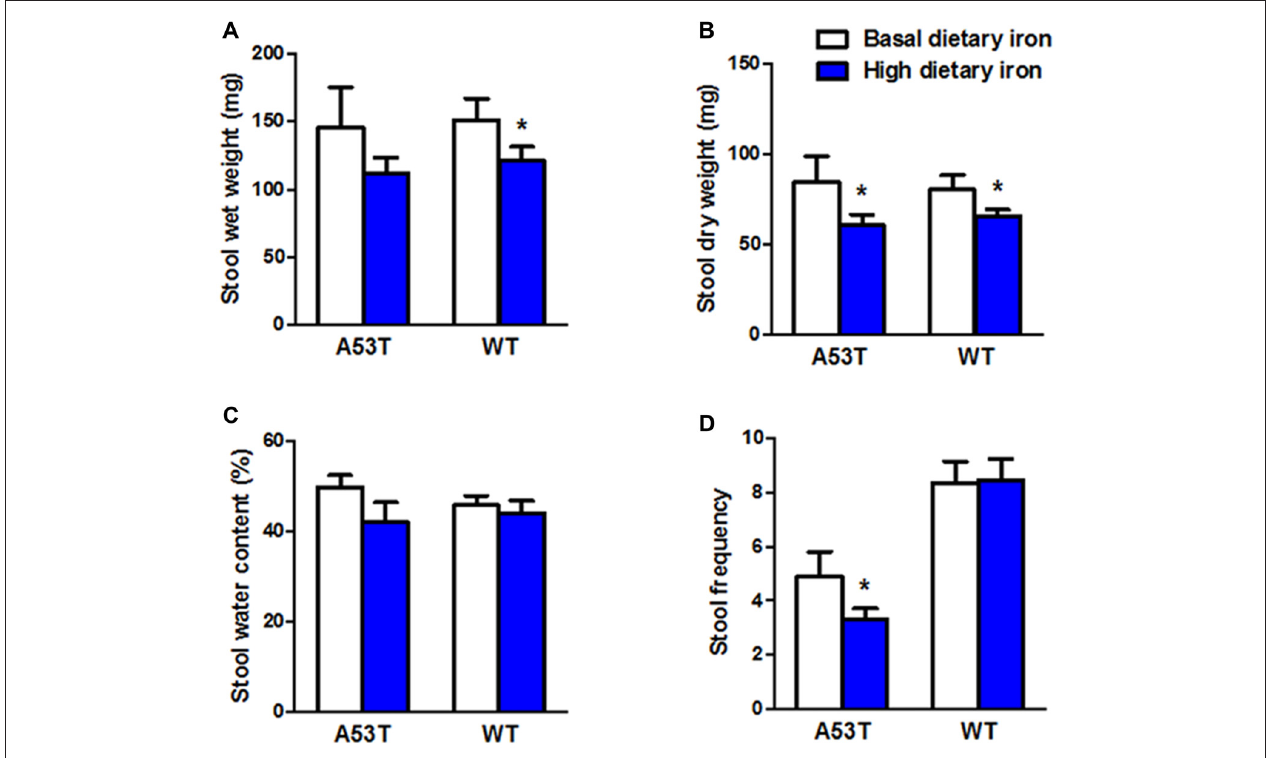
FIGURE 2 | Changes of colonic motility in A53T and WT mice with high dietary iron. The colonic motility was observed in A53T mice and WT mice. In A53T mice, dry weight of stool (B) and stool frequency (D) in the high dietary iron group were lower than the basal dietary iron group, although no changes were observed in wet weight of stool (A) and water content of stool (C) . In WT mice, compared to the basal dietary iron group, the high dietary iron group showed decreased wet weight of stool (A) and dry weight of stool (B) , although there were no variations either in water content of stool (C) or stool frequency (D) . Each bar represented the mean ± SEM. ∗ P < 0.05, compared with the corresponding basal dietary iron group, n =